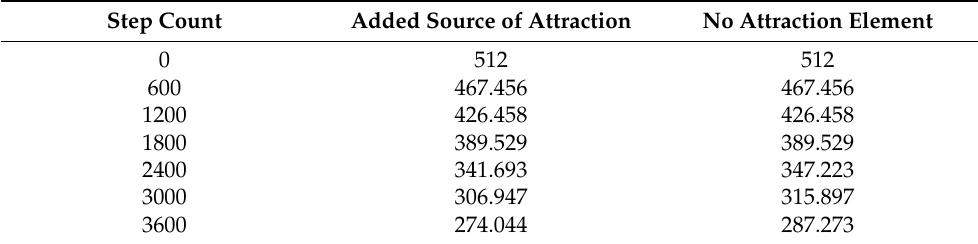
Table 6. Comparison of steps taken to find the target.